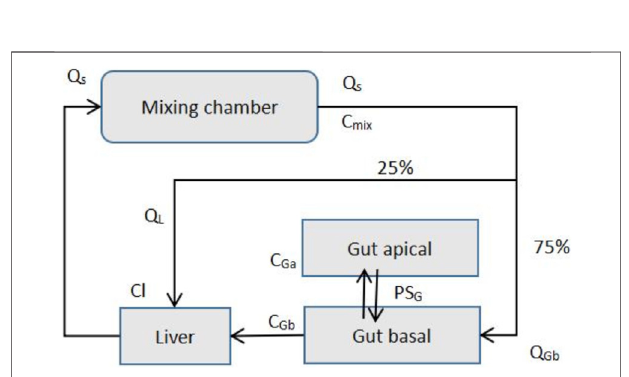
FIGURE 7 | MIT gut-liver MPS Platform (Adapted from Kasendra et al.,